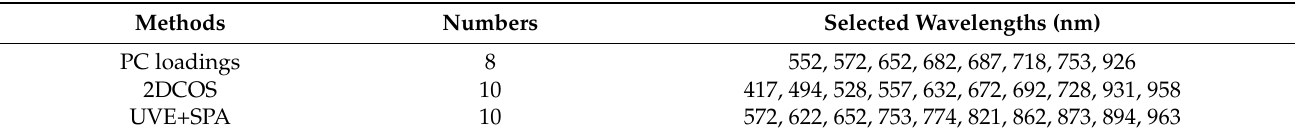
Table 3. Wavelength selection by different methods.